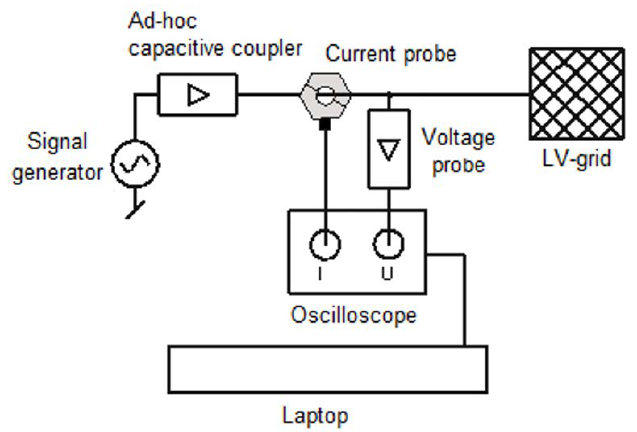
Figure 4. Measurement setup of the method developed by the UPV / EHU for the grid impedance measurement.